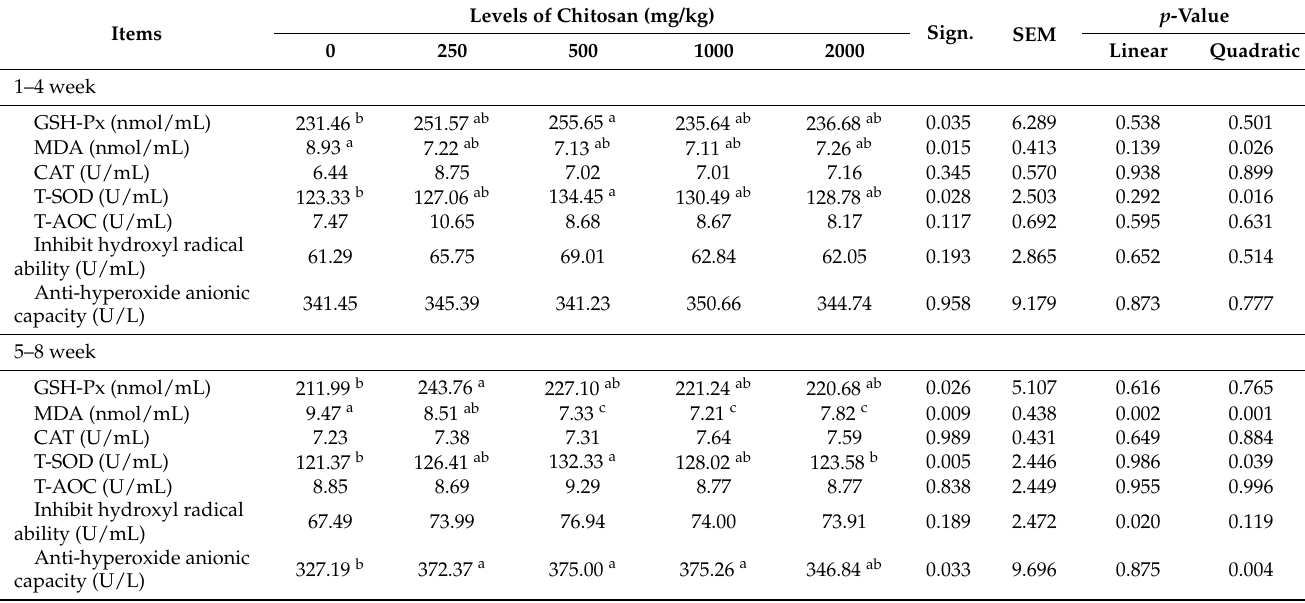
Table 4. Effect of dietary chitosan supplementation on serum antioxidant variables of laying